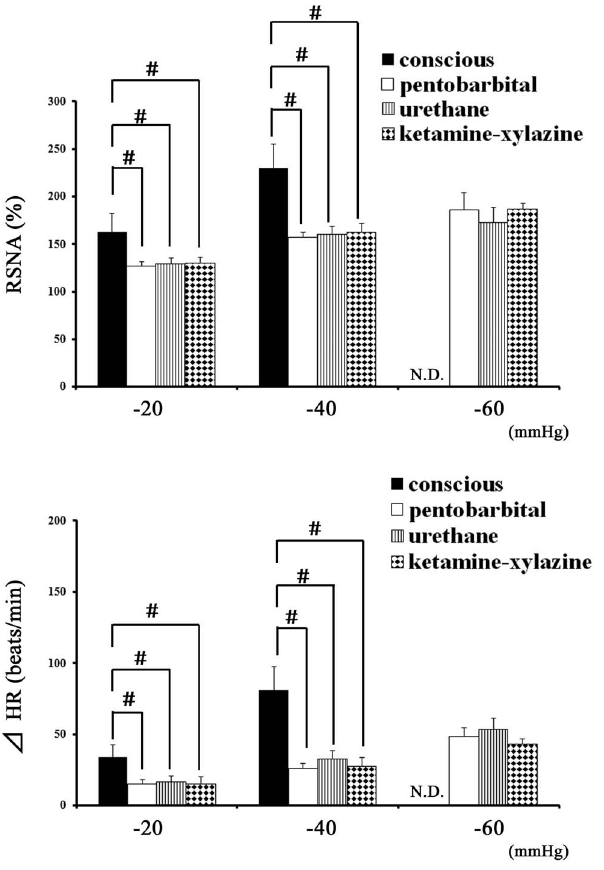
Figure 3. RSNA and HR responses to hypotension with an intravenous injection of SNP in conscious and anesthetized rats. RSNA (A) and HR (B) responses to the decrease in blood pressure ( 2 20, 2 40 and 2 60 mmHg) induced by the SNP injections in the conscious rats (black bar, n 5 5) and the rats anesthetized with pentobarbital sodium (white bar, n 5 6), urethane (vertical-striped bar, n 5 6) or ketamine-xylazine (black bar with white diamond, n 5 6). Values are expressed as the mean + SEM. N.D.; data were not obtained because SAP did not decrease by 60 mmHg in conscious rats. # P , 0.05 vs. the conscious